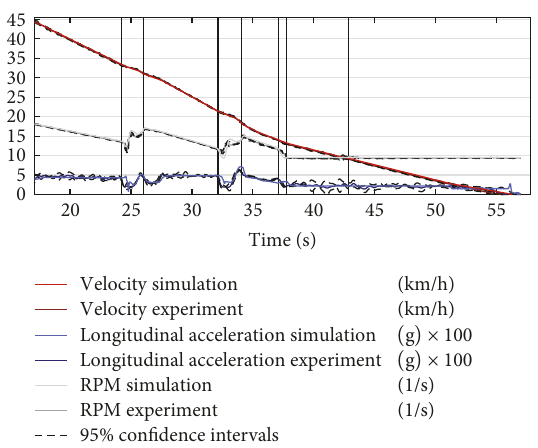
Figure 15: Validation Maneuver Long-Ic: experimental data.